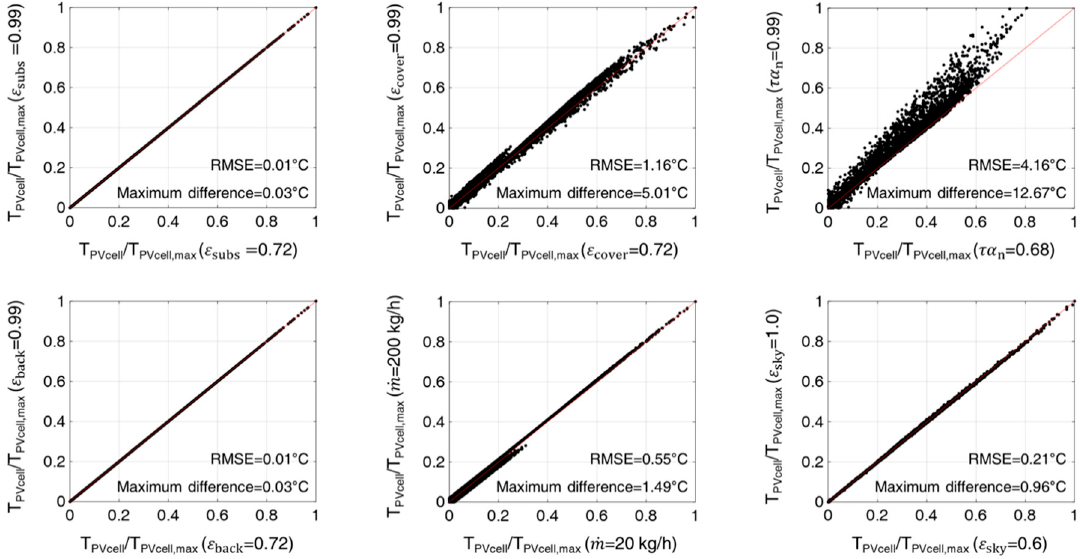
Figure 6. Scatter plots of sensitivity analysis for unknown parameters regarding BIPV cell temperatures.